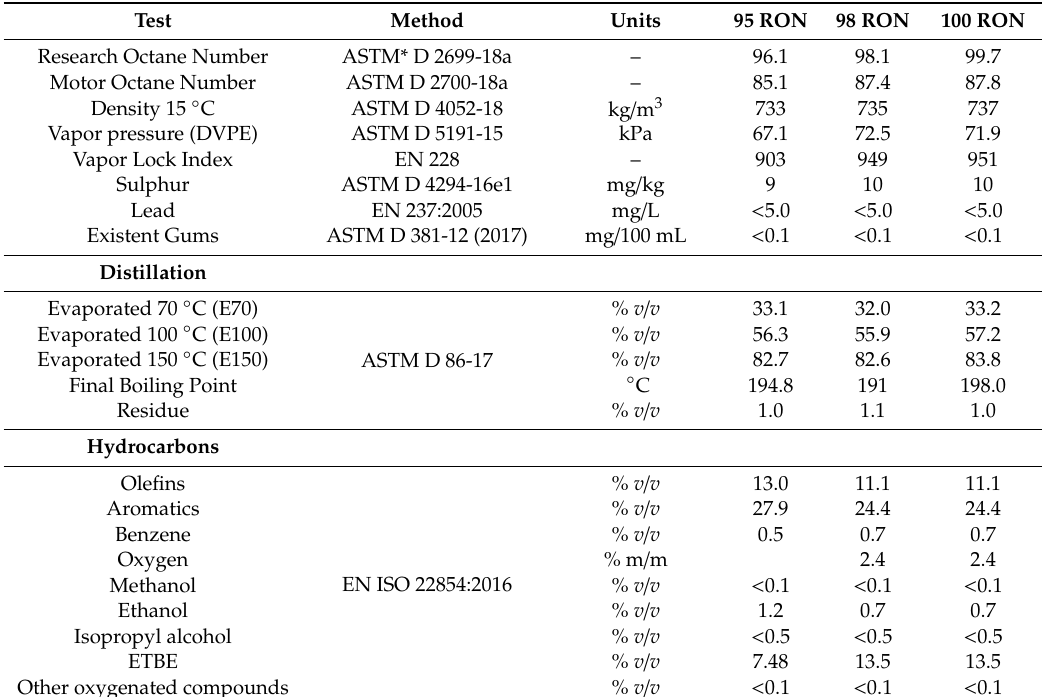
Table 3. Properties of tested